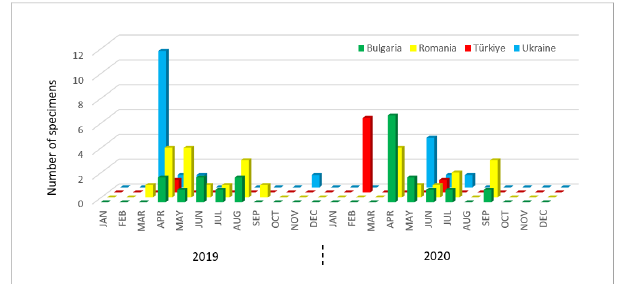
FIGURE 8 Seasonal distribution of records of stranded cetaceans with bycatch signs by Black Sea countries, 2019-2020.